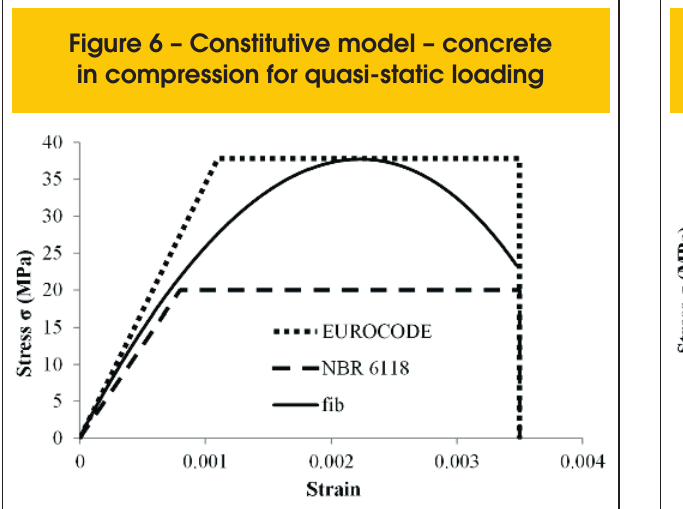
Figure 7 – Constitutive model – steel for quasi-static